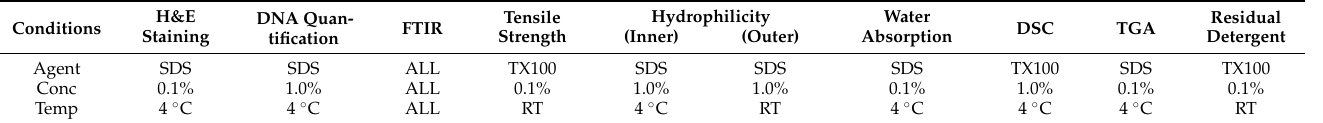
Table 2. Summary indicating the best decellularization conditions for the specific tests